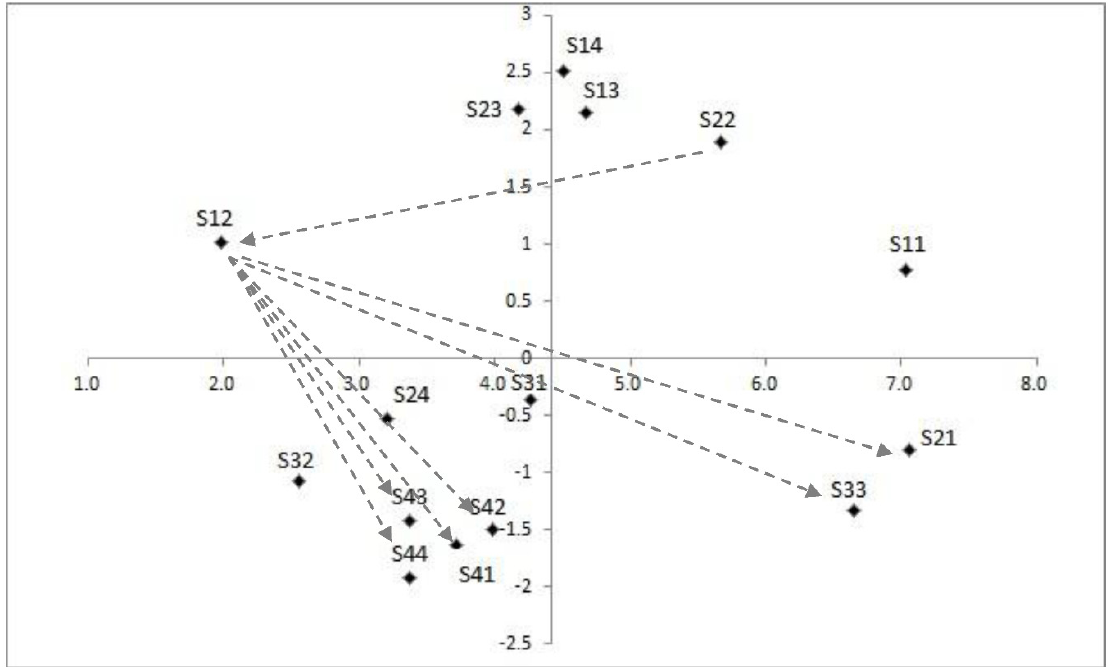
Figure A2. Casual Diagram between S12 and Other